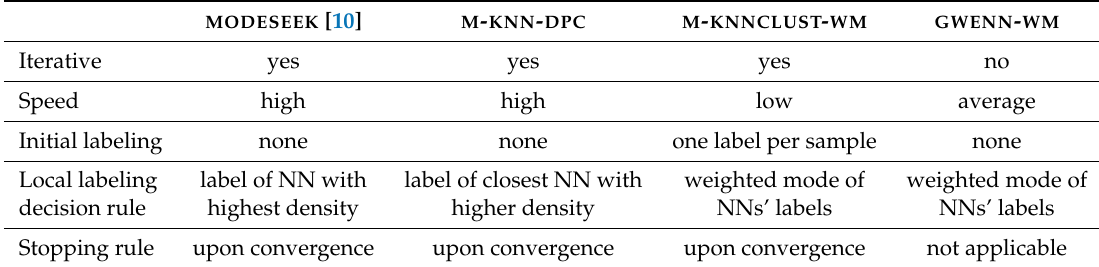
Table 2. Some properties of the nearest-neighbor density-based clustering